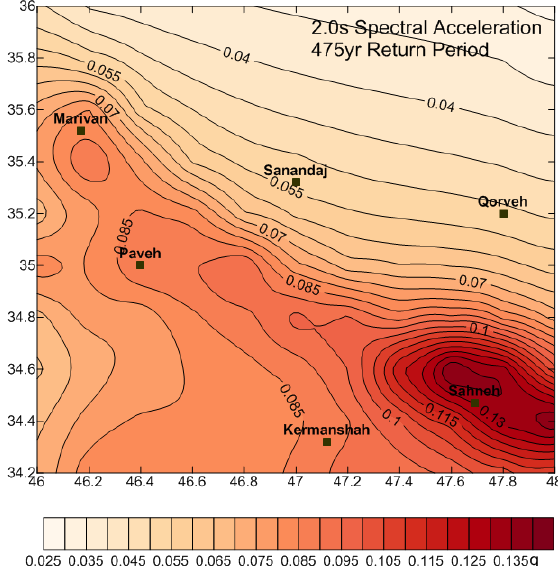
Figure 5. Seismic hazard map of the Kermanshah-Sanandaj region in terms of Sa(2.0 s) for the 50-year return period.